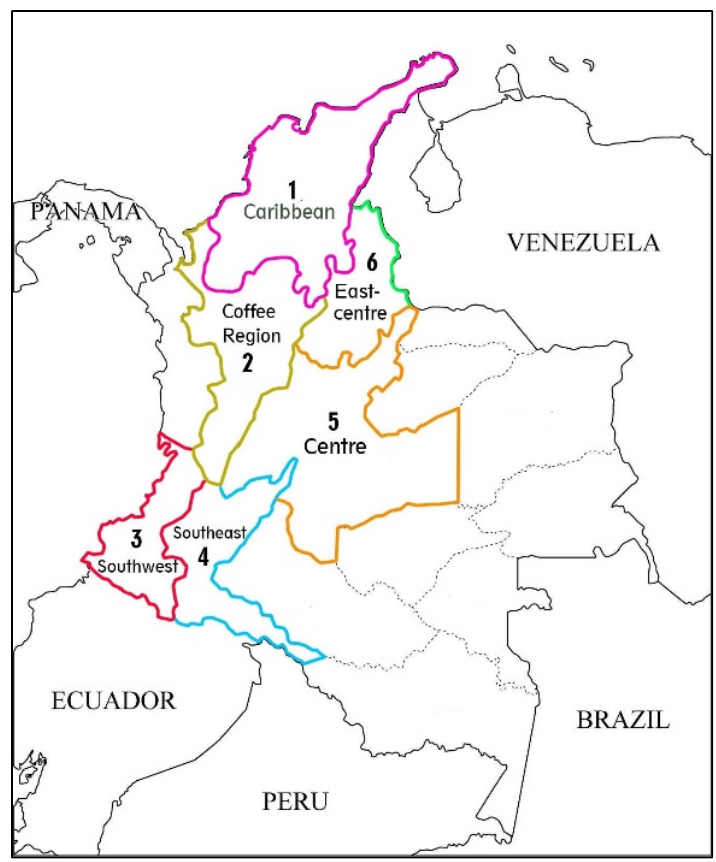
Figure 1: Regional divisions of Red de Semillas Libres de